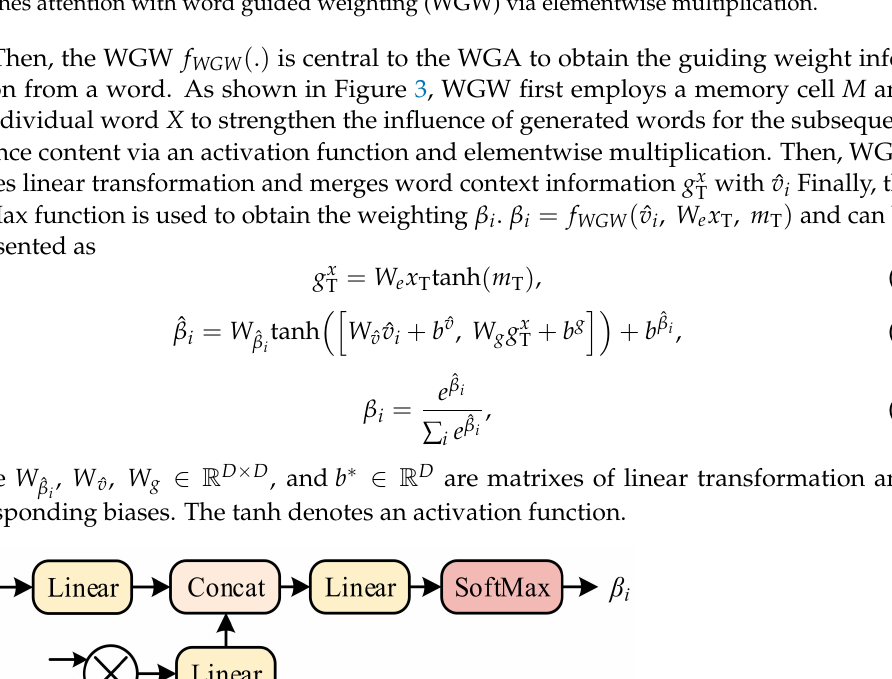
Figure 2. Illustration of a basic attention unit and WGA. ( a ) This unit produces the average weighted feature vectors by linear transformation, scaled dot-product attention, and SoftMax. ( b ) The WGA combines attention with word guided weighting (WGW) via elementwise multiplication.